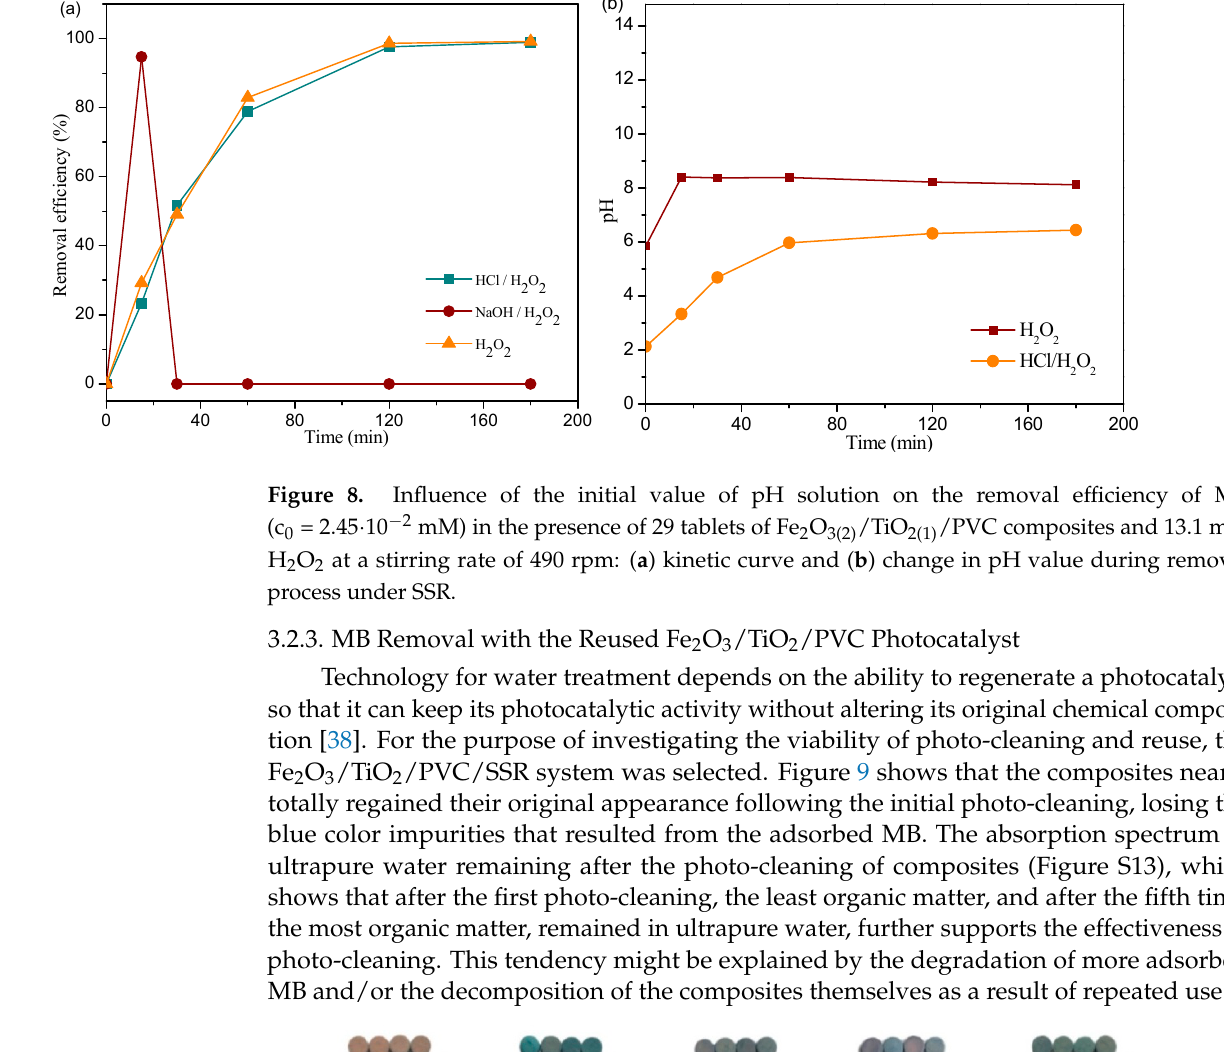
MB ( c 0 = 2.45 · 10 − 2 mM) removal under the influence of UVC irradiation for 60